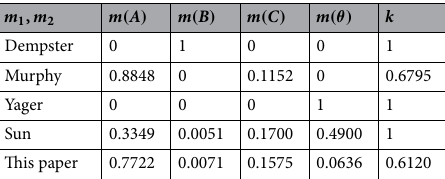
Table 2. Different algorithms deal with the problem of one vote